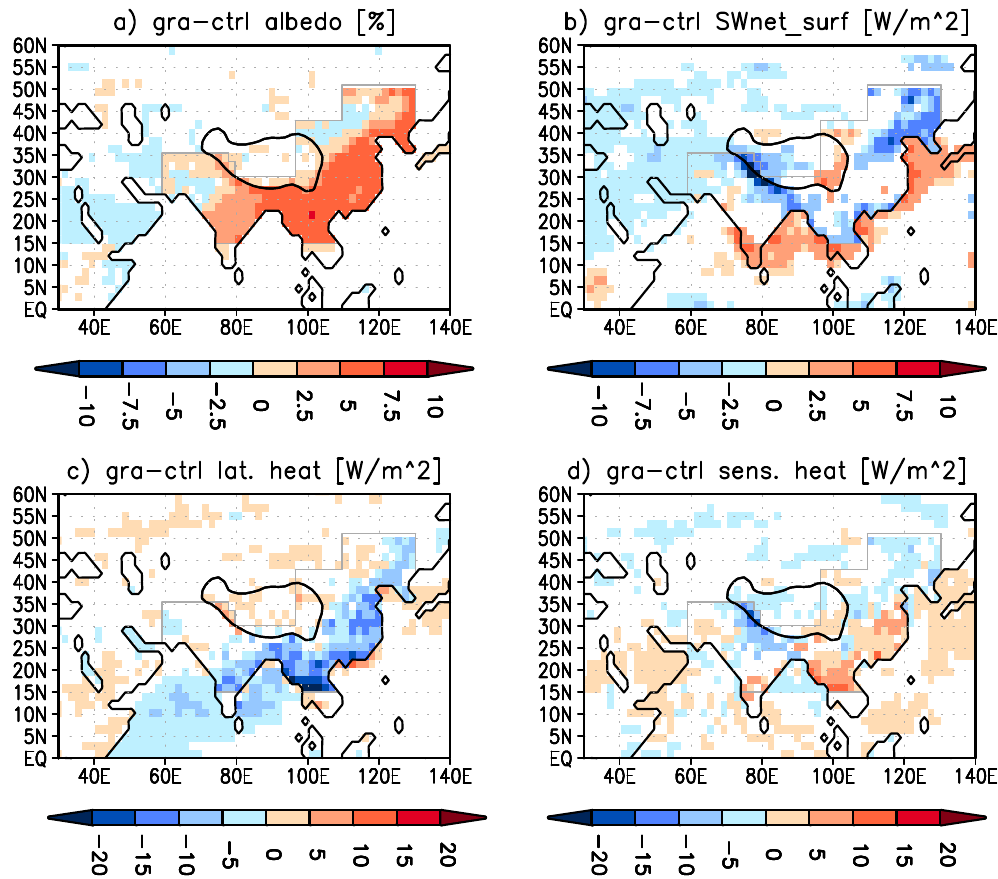
Fig. 11. Simulated change of different parameters influencing the temperature change between the deforestation experiment (gra) and the control run (ctrl), averaged over the monsoon season. For further details see Fig.